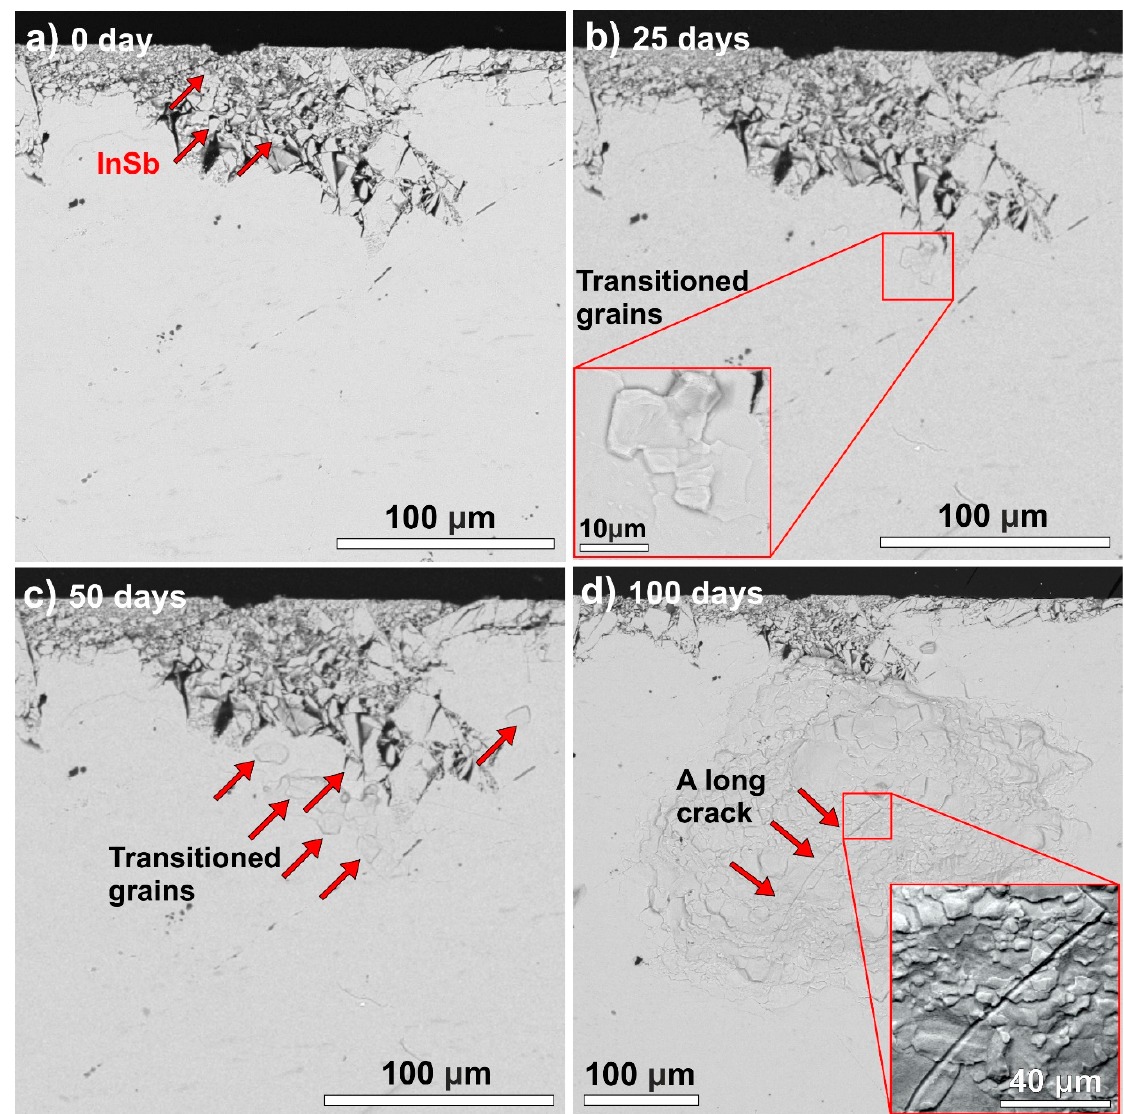
Figure 8. SEM micrographs showing the progress of the allotropic transition inside a reference body of samples inoculated with InSb at − 10 °C: ( a ) 0 days; ( b ) 25 days; ( c ) 50 days; ( d ) 100 days.